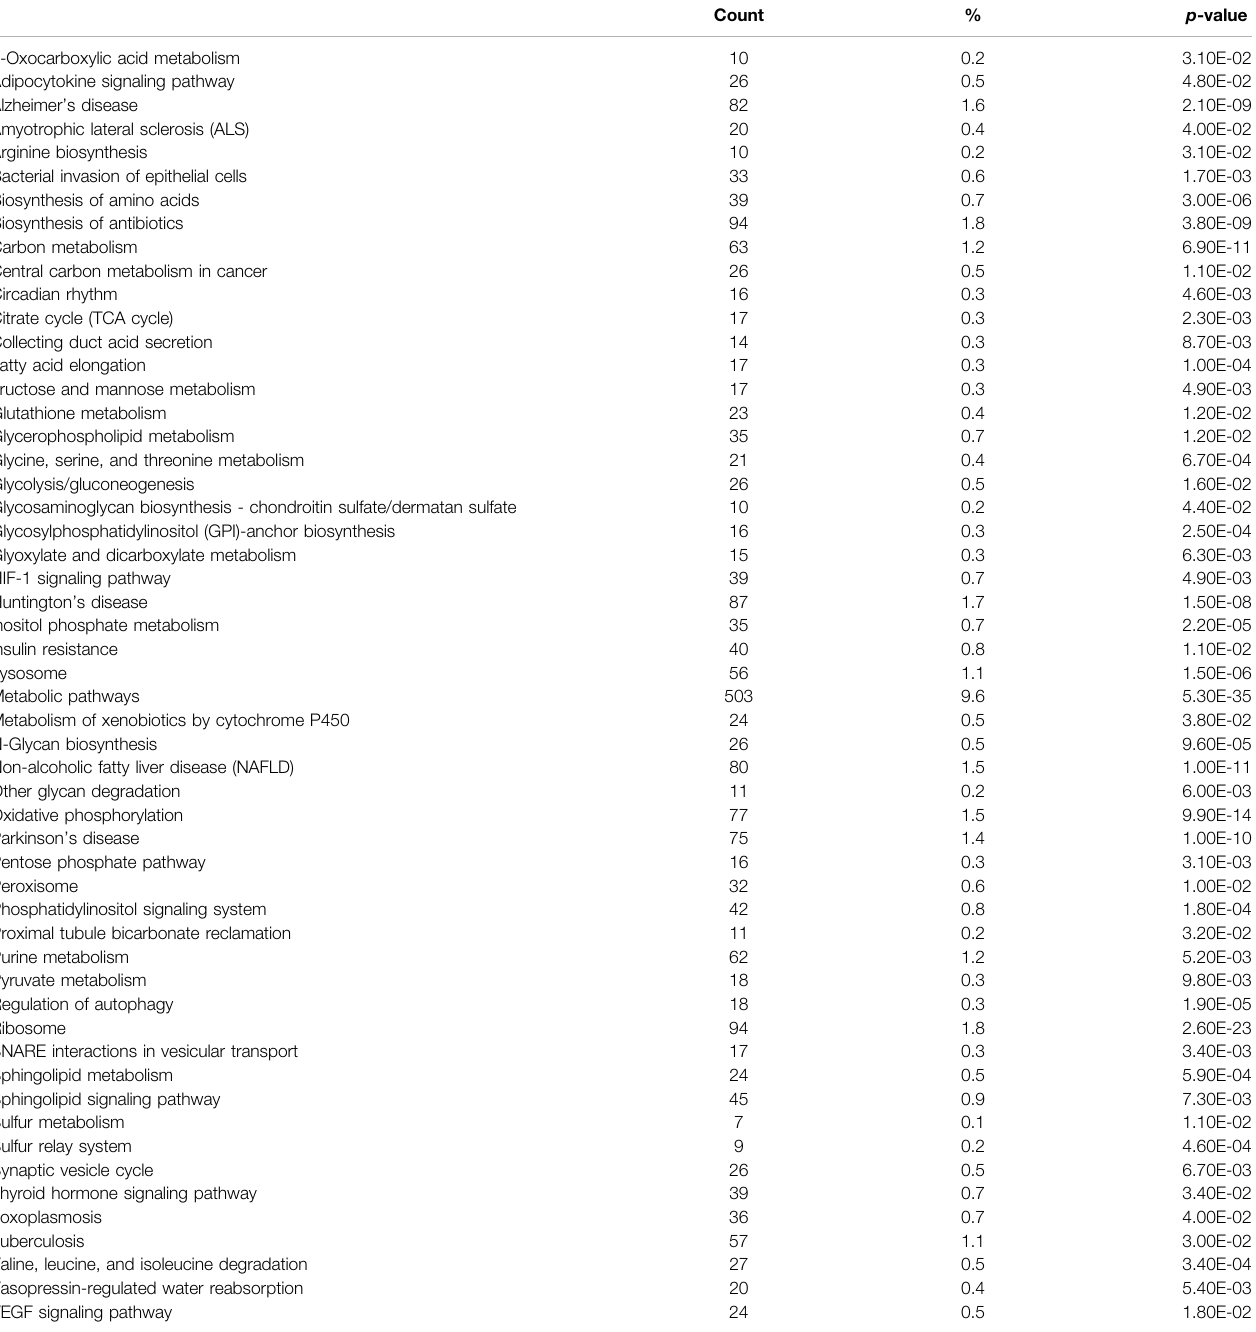
TABLE 2 | KEGG pathway analysis of the positive